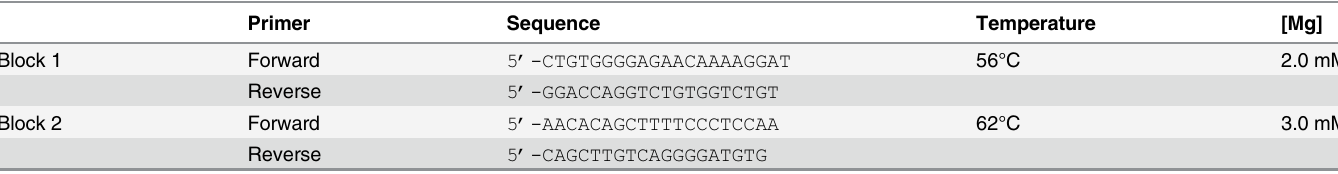
Table 1. Primer sequences and conditions for the TNF- α promoter